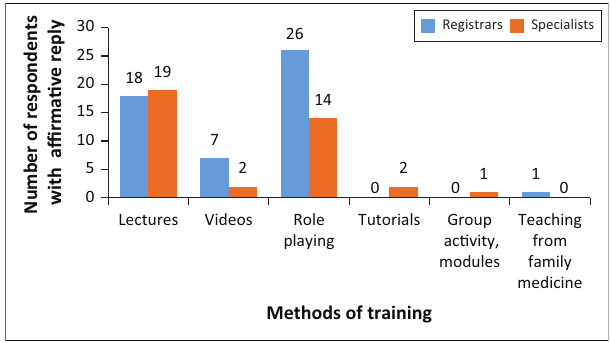
FIGURE 1: Type of training received at undergraduate level.